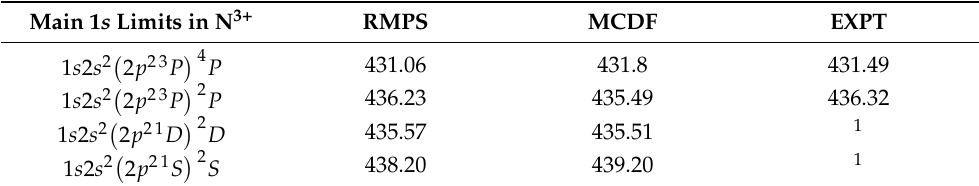
Table 4. RMPS, MCDF and experimental (see text) N 3+ series limits (eV).